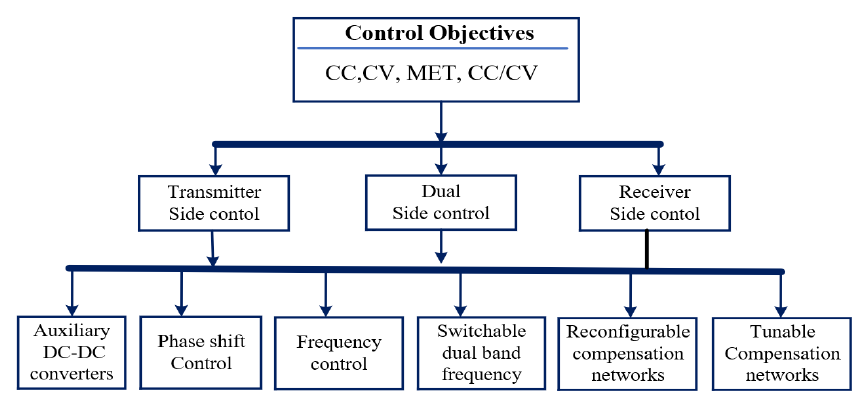
Table 5. Summary of control methodologies for IPT systems.